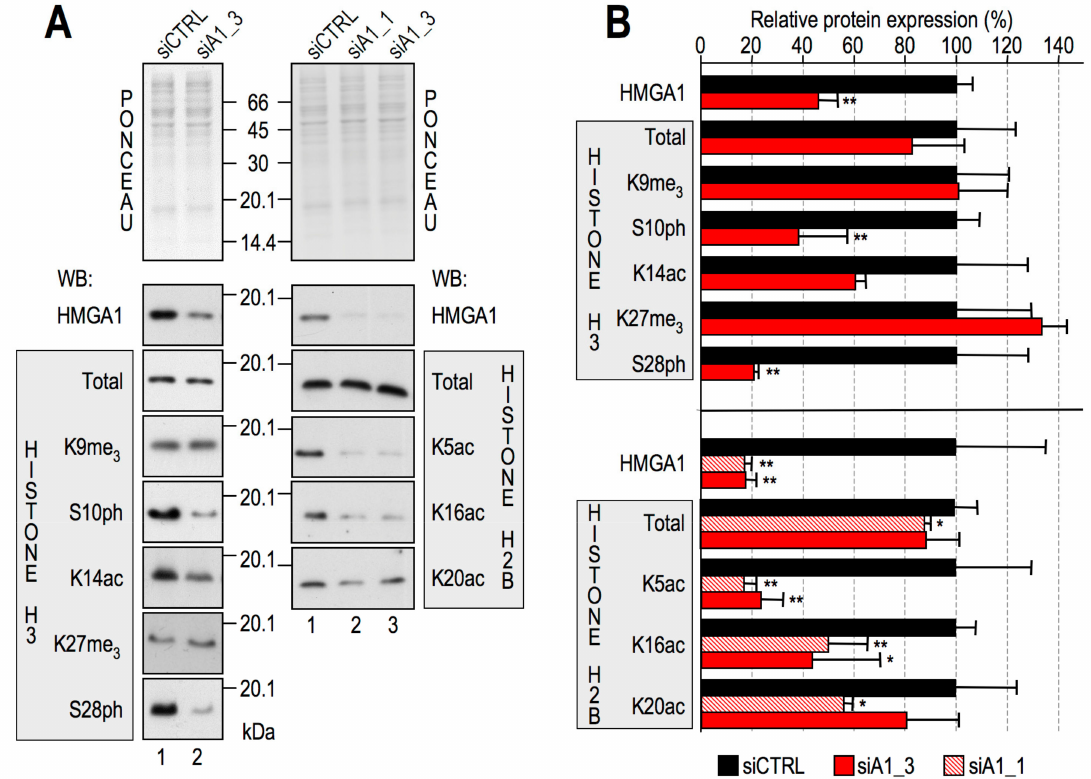
Figure 1. High Mobility Group A1 (HMGA1) a ff ects H3 and H2B post-translational modifications in MDA-MB-231 cells. ( A ) Western blot (WB) analyses of MDA-MB-231 cells transfected with control (siCTRL—lanes 1) and HMGA1–targeting (siA1_3 or siA1_1—lanes 2 and 3) small interfering